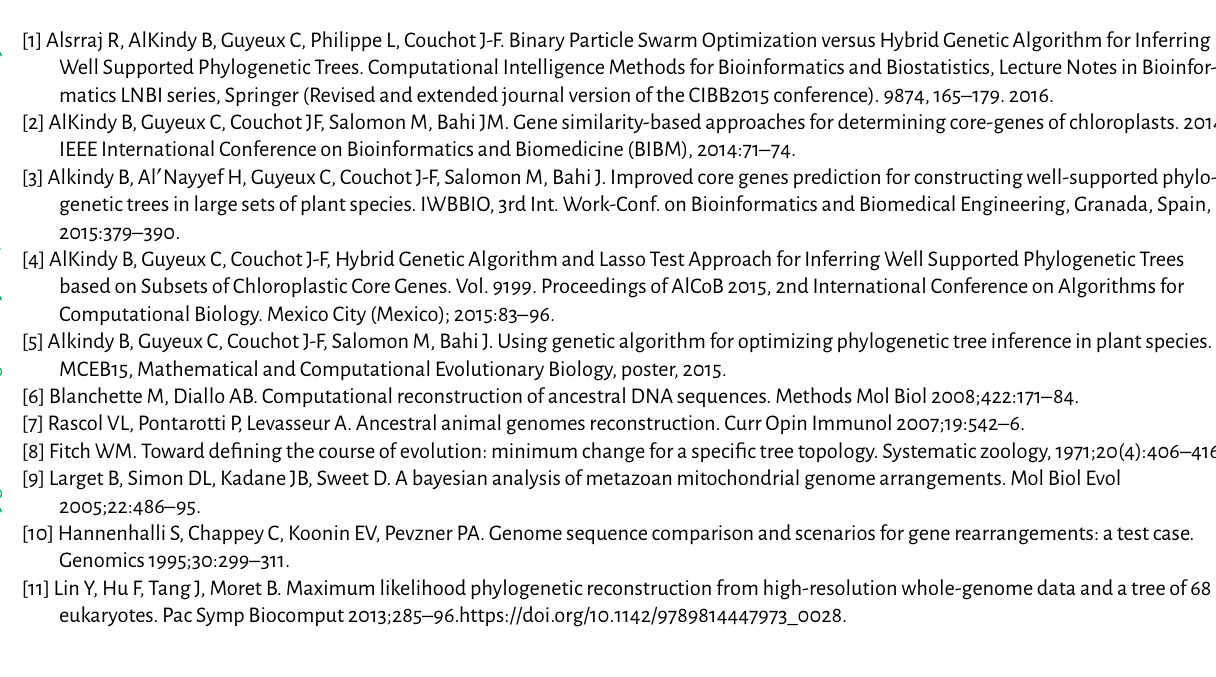
Figure 12: Green lines indicate homologuous genes while red vertices are for paraloguous ones. C line in figure (B) is the reconstructed ancestor of these two